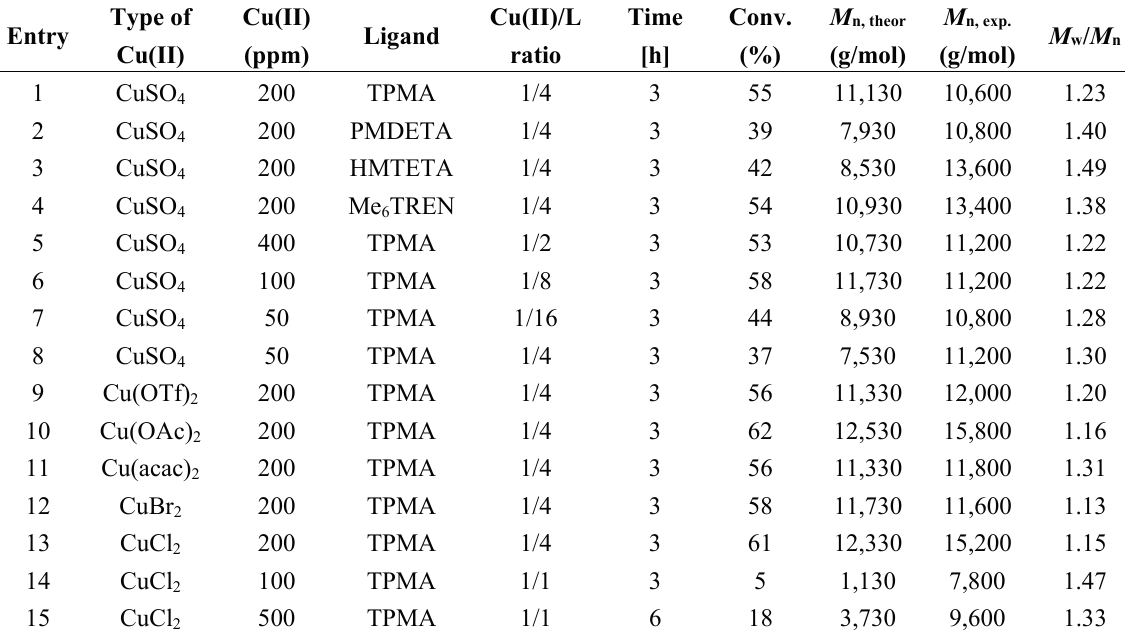
Table 1. Results of photoRDRP of methyl methacrylate. Polymerizations were performed in 25 vol% DMSO at 35 °C with a monomer/initiator ratio of 200/1. Concentration of Cu II catalyst in ppm with respect to that of the monomer; 2-bromopropionitrile and 2-chloropropionitrile were used as initiators in Entries 1–13 and 14–15, respectively. Monomer conversion was determined from 1 H NMR spectra and molar mass and dispersity by GPC using PMMA